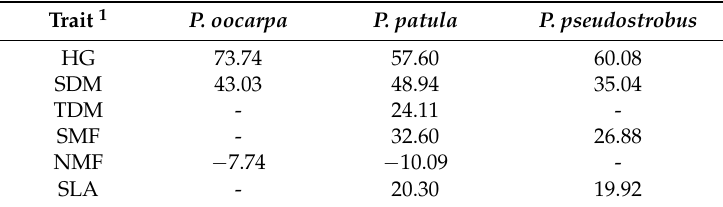
Table 4. Plasticity Index of the traits under the drought stress treatment at the species level in three Mexican pines (only variables with a Watering significant effect are